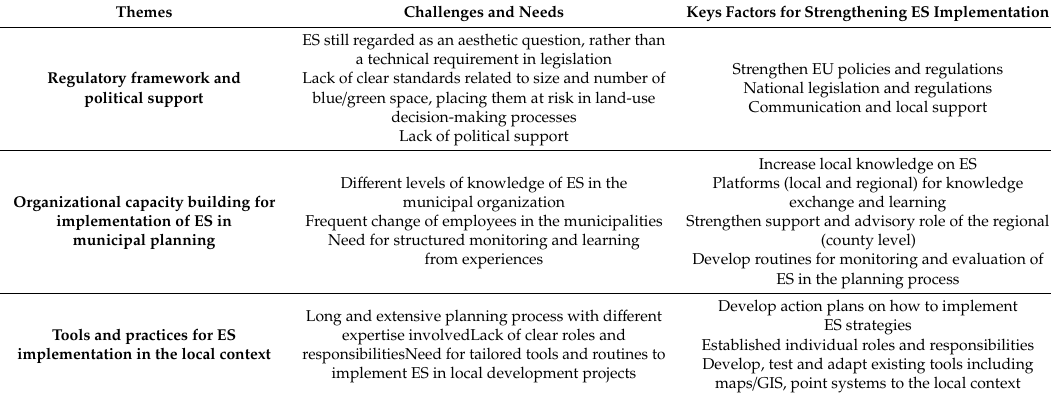
Table 3. Summary of challenges and key factors for strengthening ES